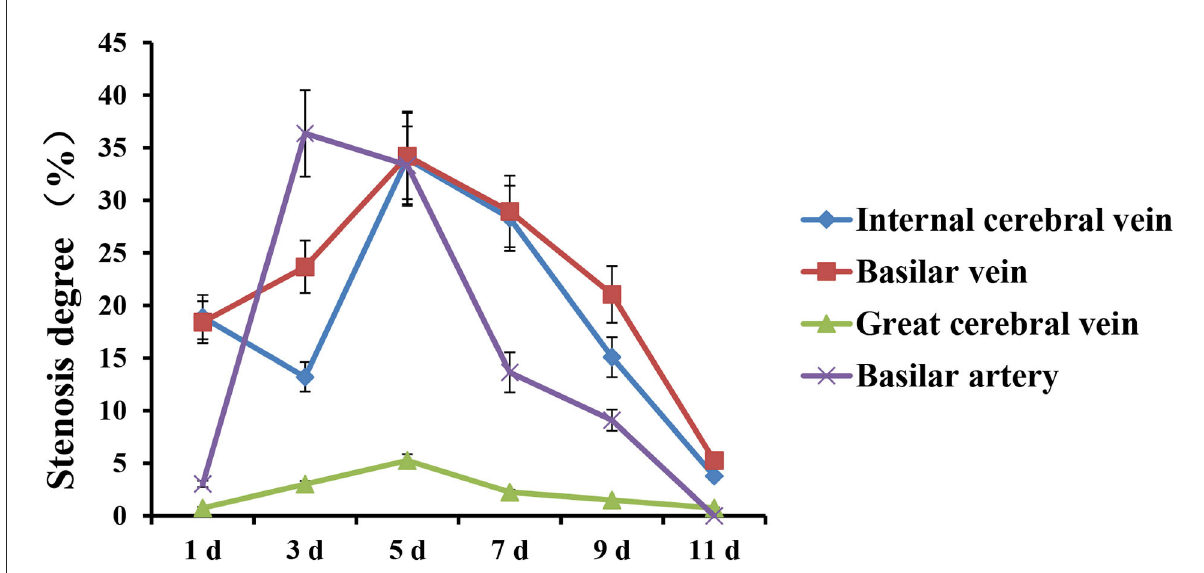
FIGURE5 The trends of stenosis degree of deep cerebral veins and basilar artery in rabbit SAH model within 0 ∼ 11 d.